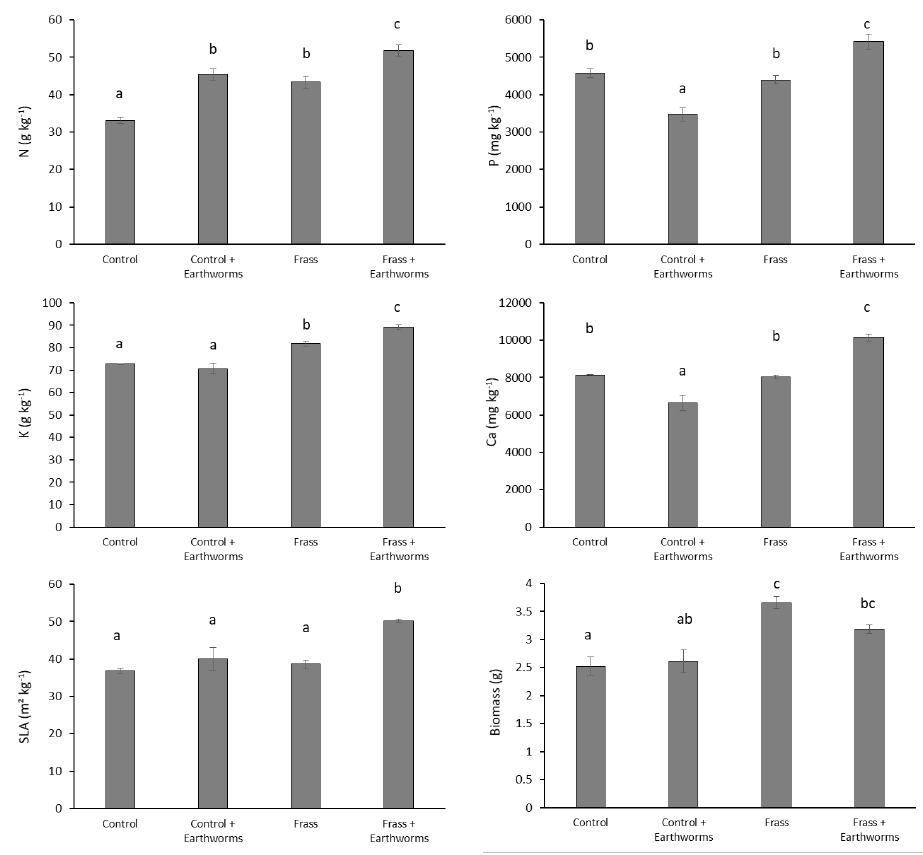
Figure 2. Concentrations of N, P, K, and Ca, specific leaf area (SLA), and biomass of barley. Values are average (n = 4) ± standard error. Columns with the same letter do not differ significantly at the 5% are average (n = 4) ± standard error. Columns with the same letter do not di ff er significantly at the level. 5%